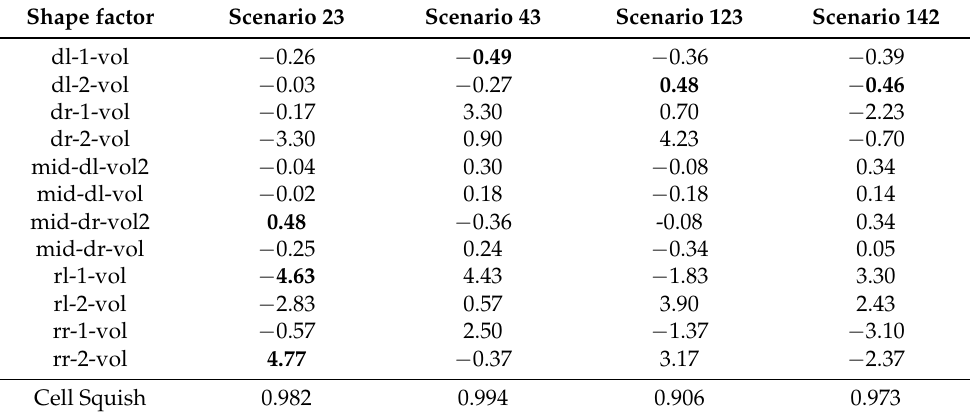
Table 1. Four worst-case scenarios presenting the greatest mesh quality degradation. The amplifica- tion shape factors close to the range boundaries are shown in bold